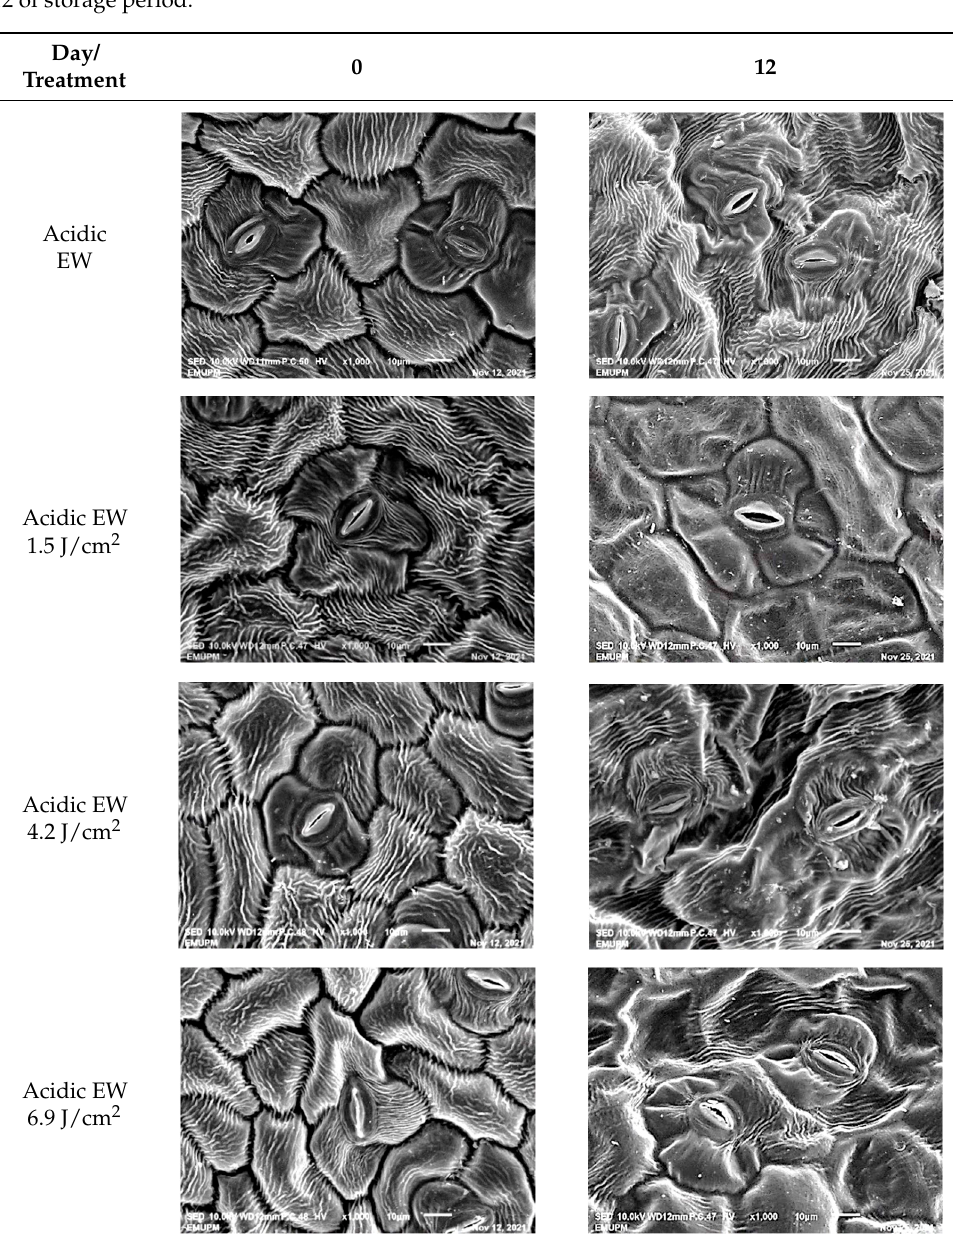
Table 1. Scanning electron microscopic (SEM) images of fresh-cut pennywort leaves on day 0 and 12 of storage period.